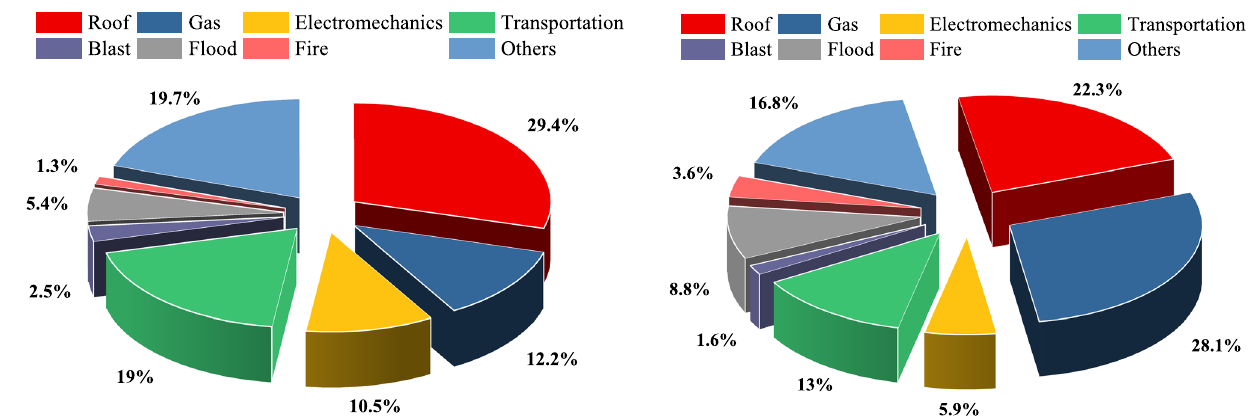
Fig. 7 Proportion of quantity and death based on different